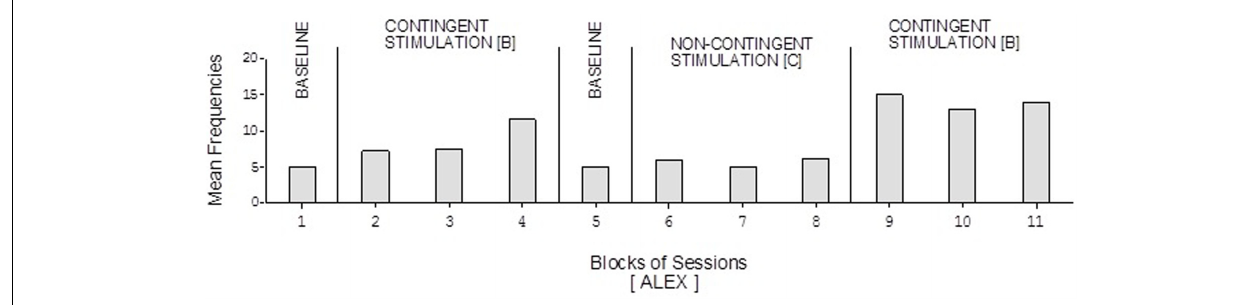
FIGURE 3 |Alex’s data plotted as in Figure 2.